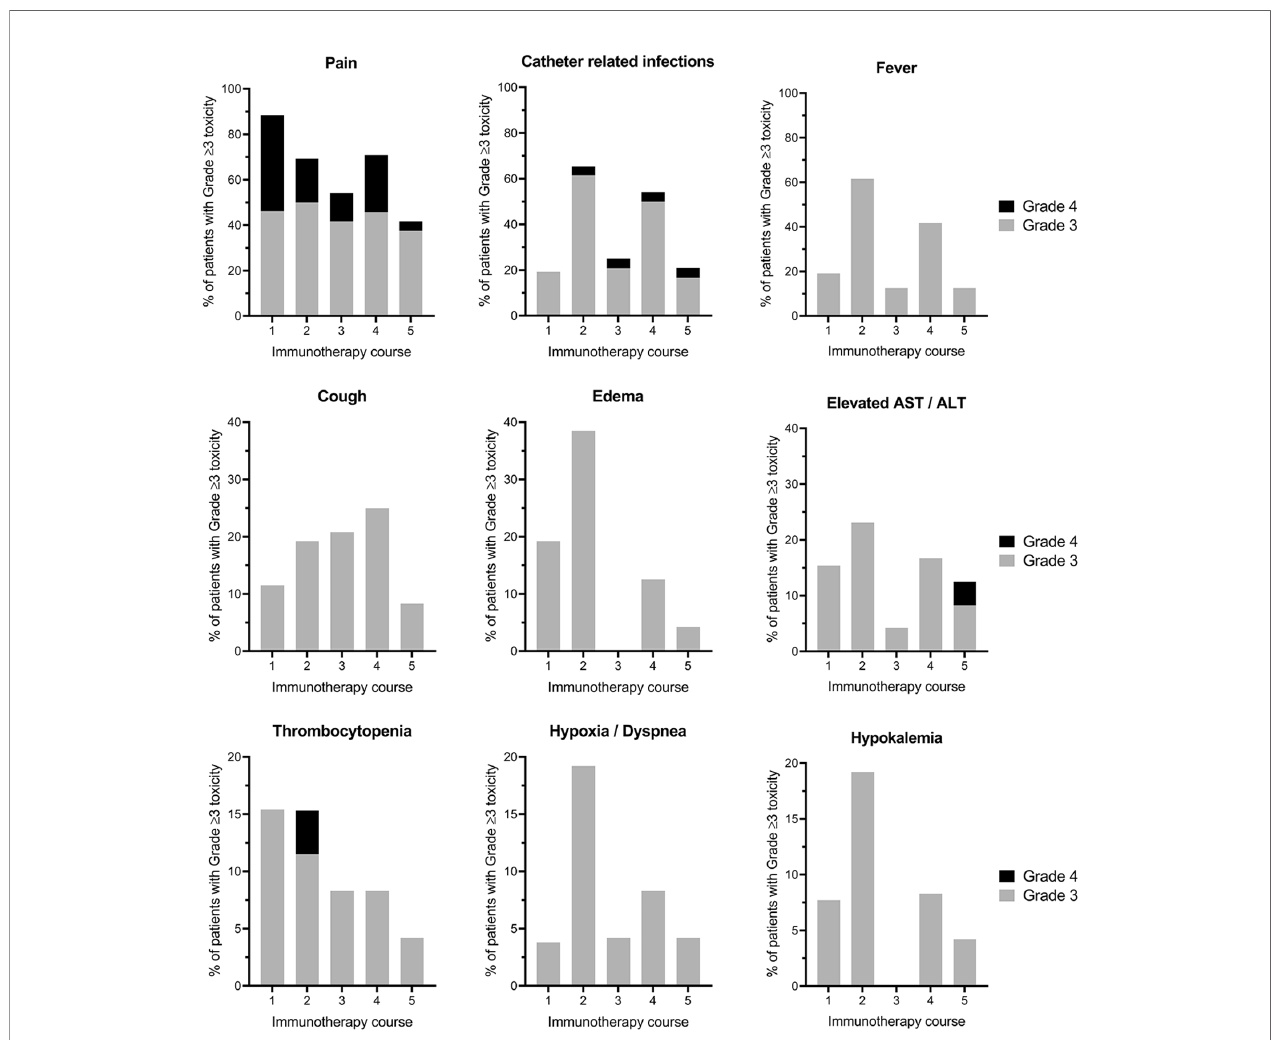
FIGURE 1 | The most prevalent immunotherapy-related grade ≥ 3 toxicities per course. Proportion of patients experiencing grade ≥ 3 toxicities per cycle (1 – 5) of immunotherapy are displayed. The highest grade of toxicity per patient per course is shown. Please note the different scales of the Y-axis. AST, Aspartate transaminase; ALT, Alanine